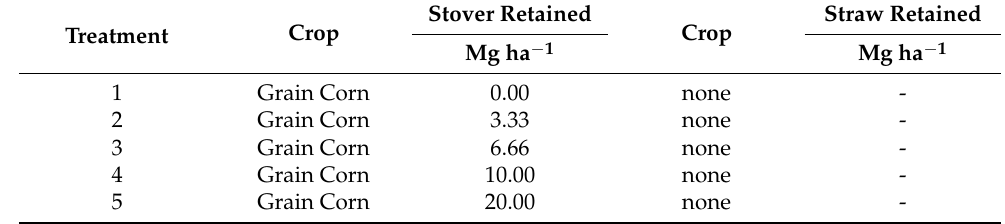
Table 1. Residue sources and application rates for a residue management field-based experiment in a continuous corn rotation in Blacksburg, VA.